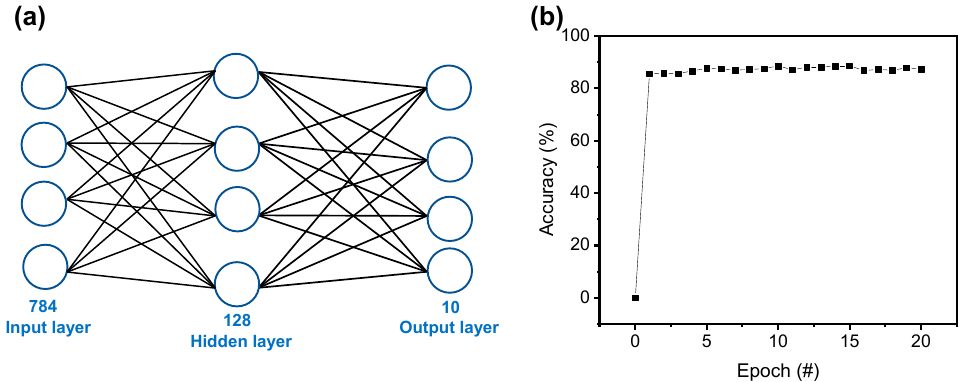
Figure 5. ( a ) Neural network including the input layer, hidden layer, and output layer. ( b ) Pattern recognition accuracy.